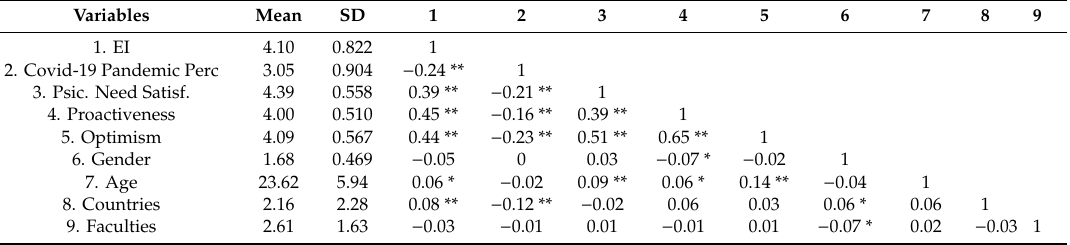
Table 1. Means, standard deviations, and correlations among variables (N =